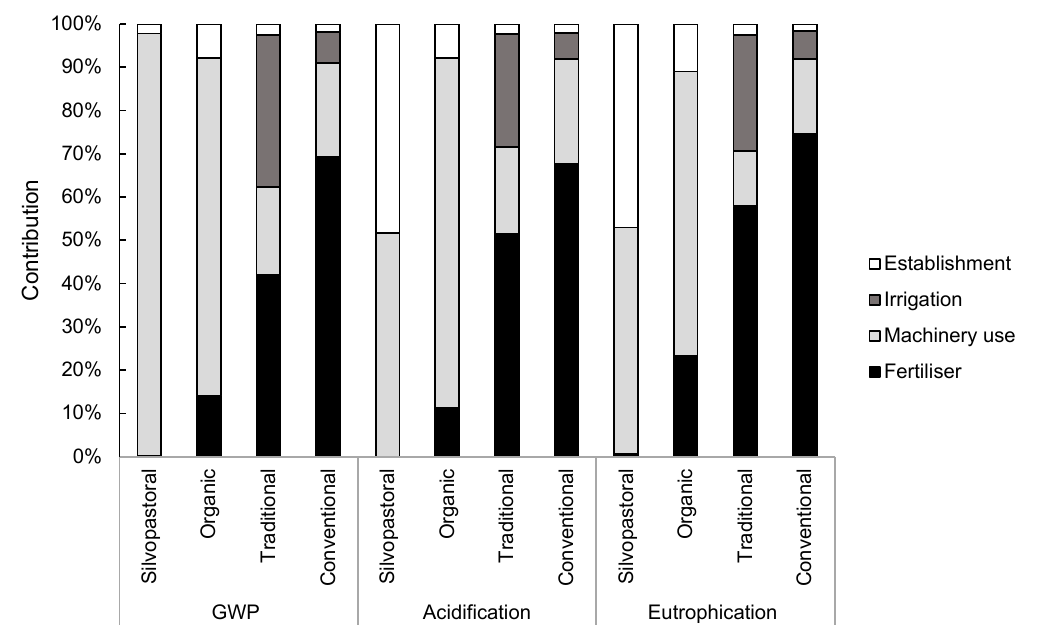
Figure 3. Percentage contribution from fertilizer, machinery use, irrigation, and orchard establishment on environmental impacts categories of global warming potential (GWP), acidification, and eutrophication for four Italian production systems.